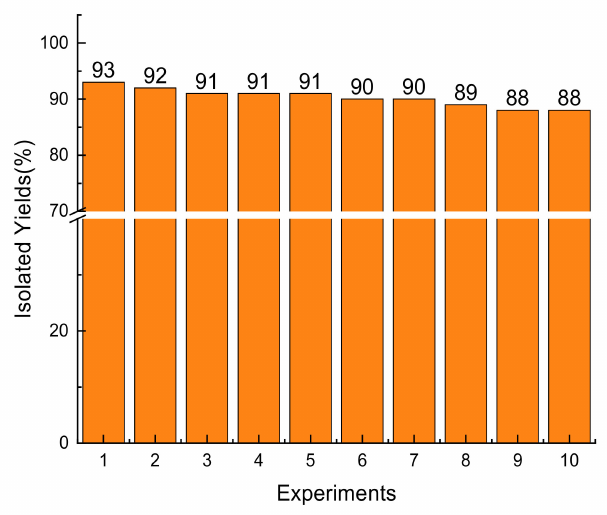
Figure 1. Recycling